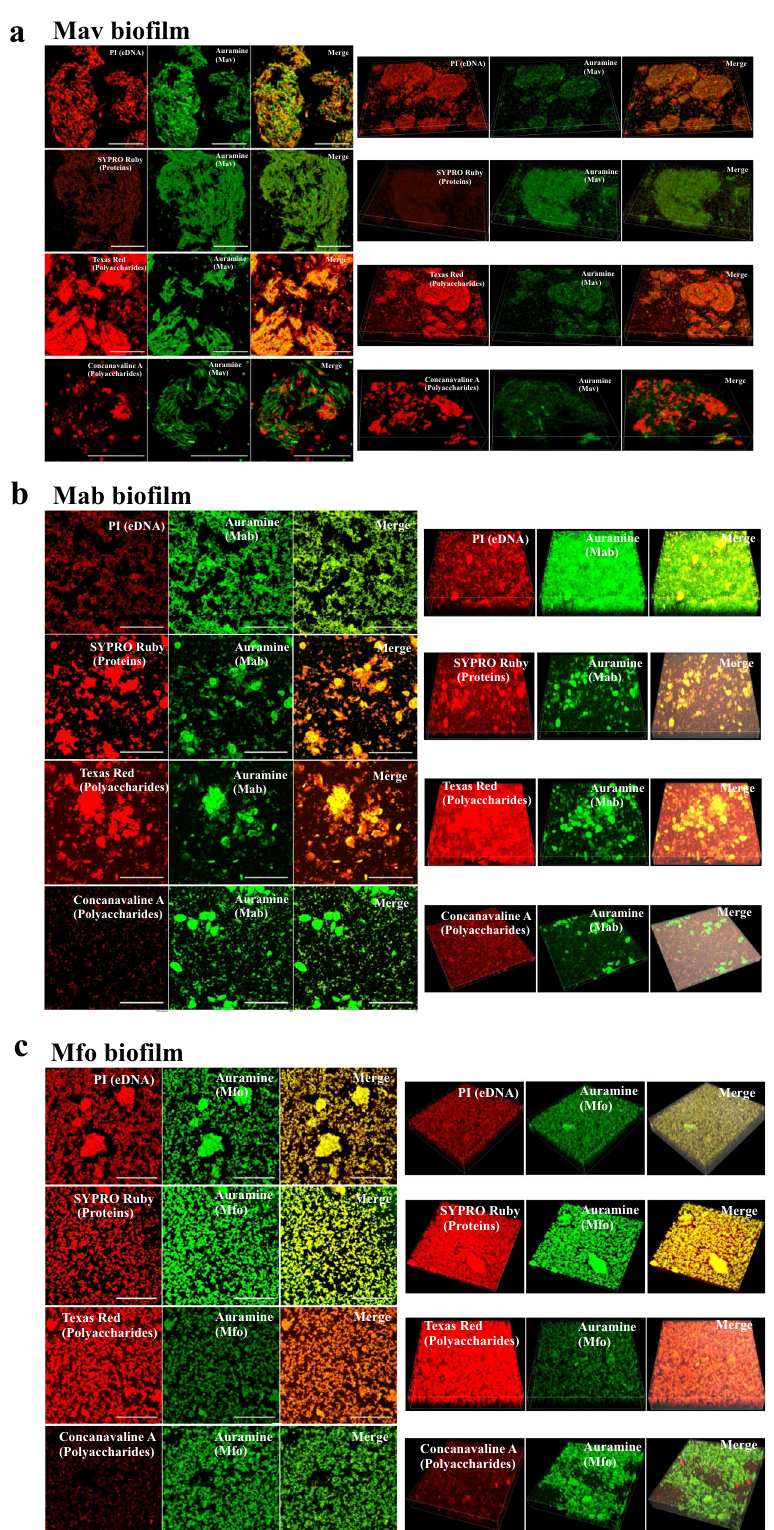
Fig. 2 Characterization of thiol reductive stress-induced bio fi lm matrices in NTMs. a – c To characterize the chemical nature of the extracellular matrix of thiol reductive stress-induced bio fi lms, Mav ( a ), Mab ( b ) and Mfo ( c ) cultures were subjected to 6 mM DTT for 29 h and then stained with PI (for eDNA), SYPRO Ruby (for proteins), Texas red (for polysaccharides) and Concanavalin A (for α -glucopyranosyl and α -mannopyranosyl residues). NTM cells were stained with phenolic Auramine O – Rhodamine B and analyzed using CLSM. All data are representative of three independent biological experiments. Scale bars indicate 10 µ